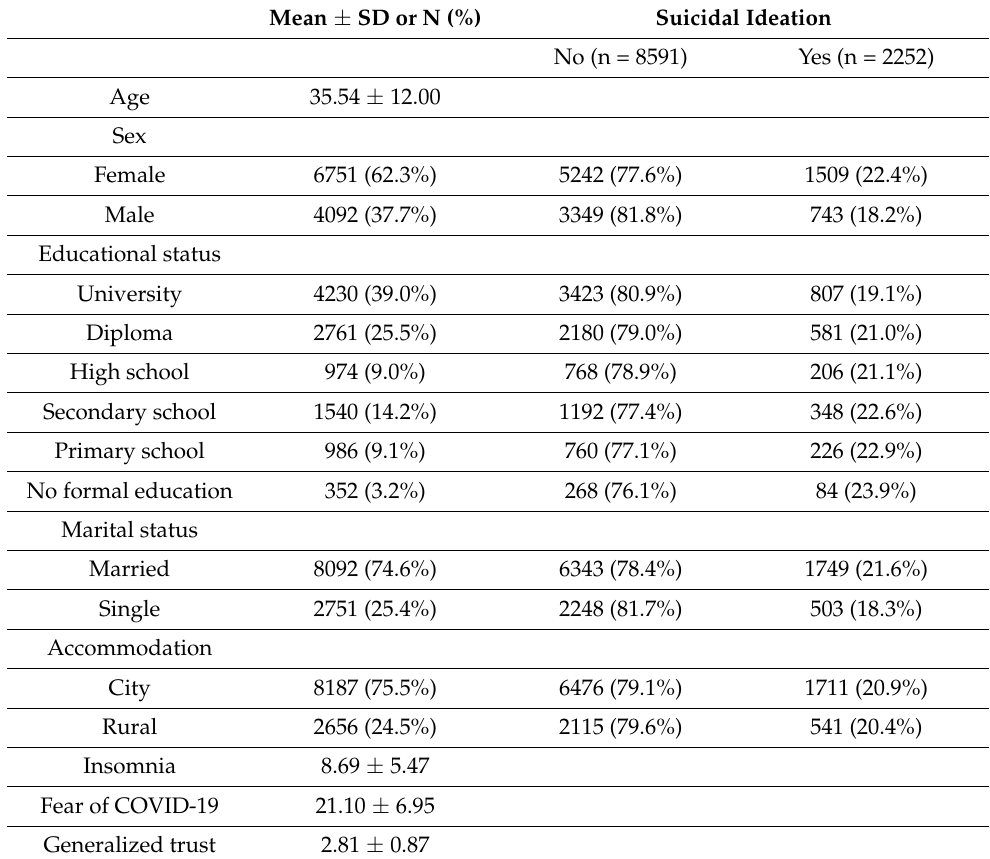
Table 1. The demographic characteristics of study participants (n =